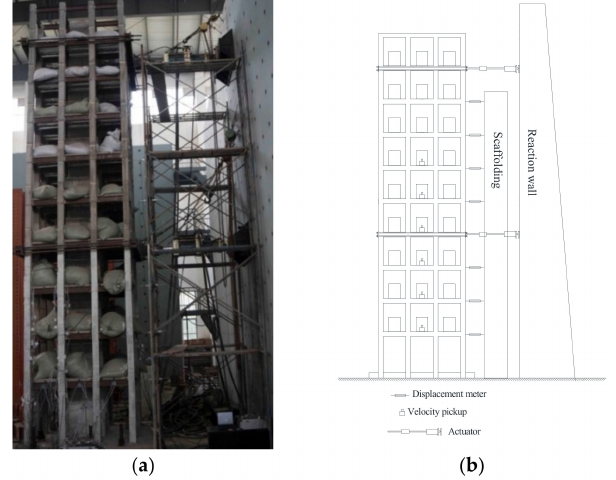
Figure 4. Test setup: ( a ) Test specimen and ( b ) Arrangement of instruments.